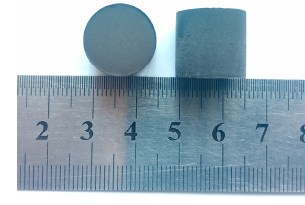
Figure 3. Photo of the CCB.